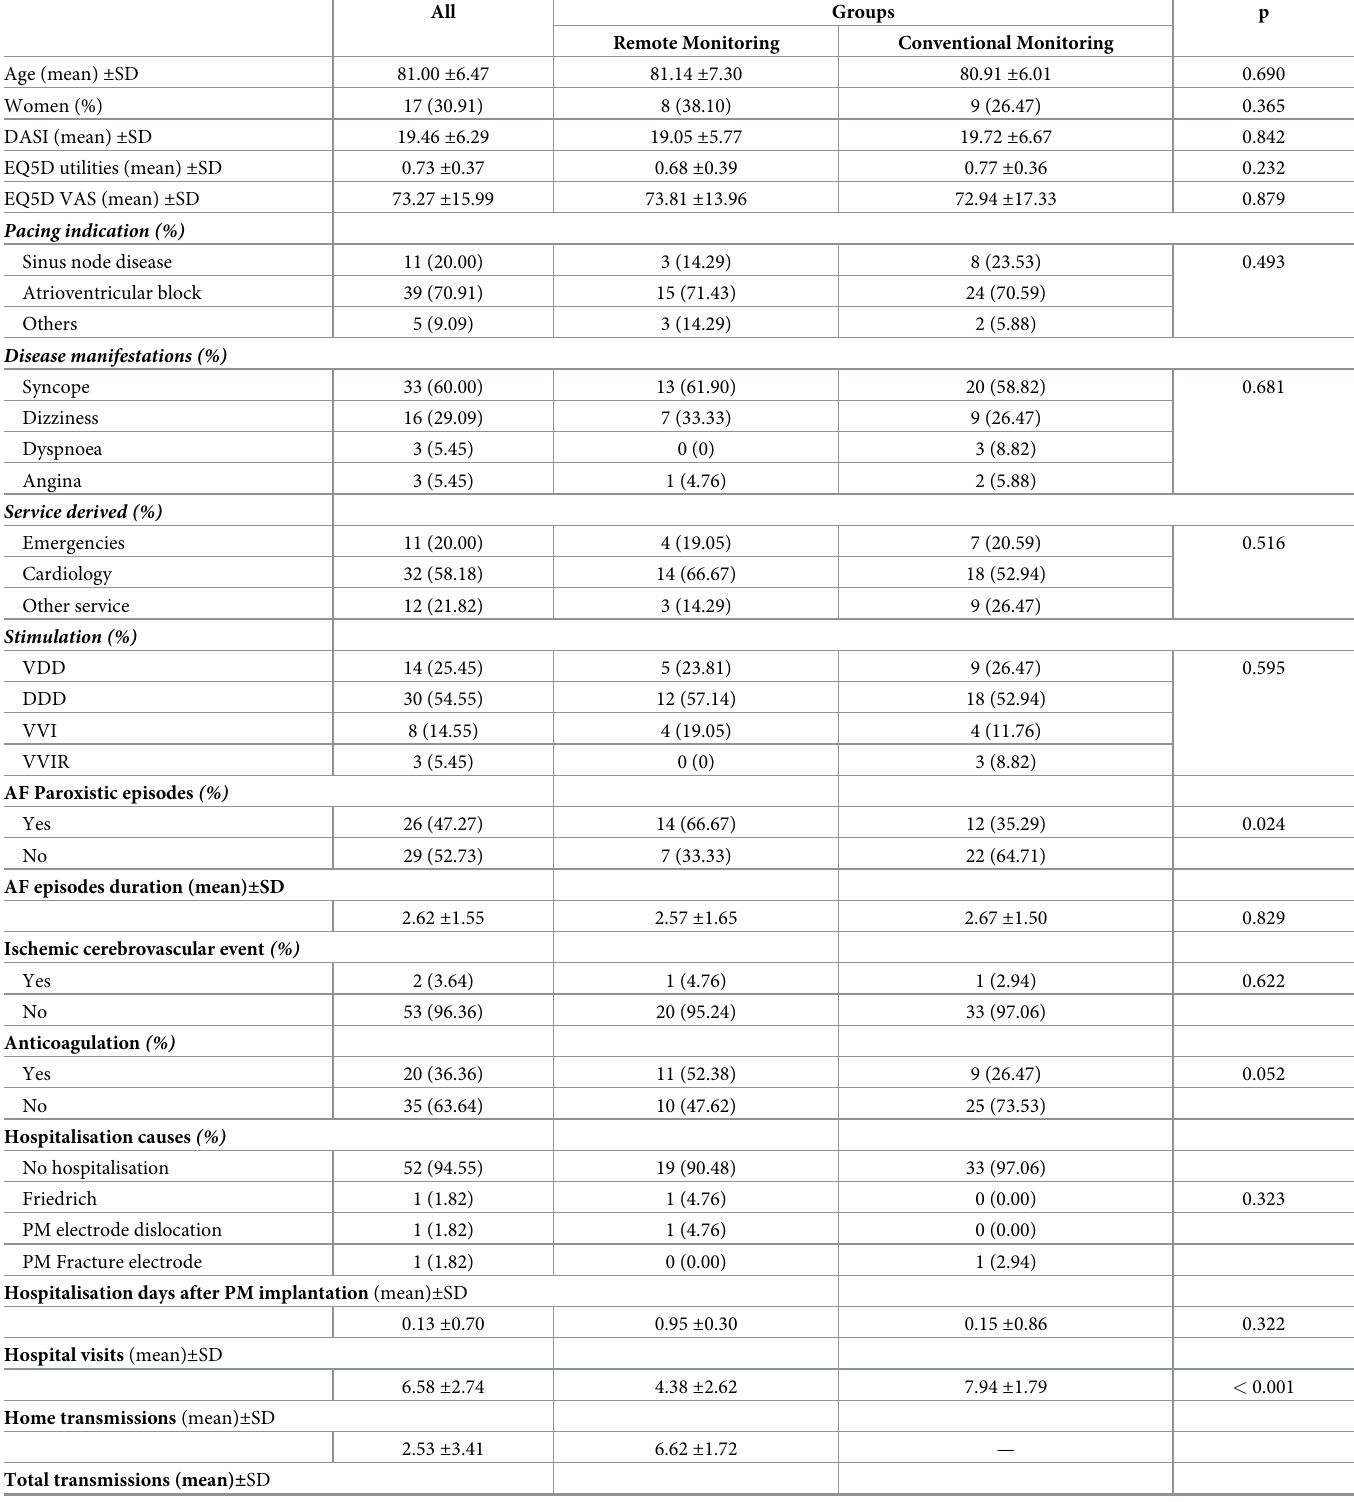
Table 2. Selected patient baseline characteristics by intervention status five years after